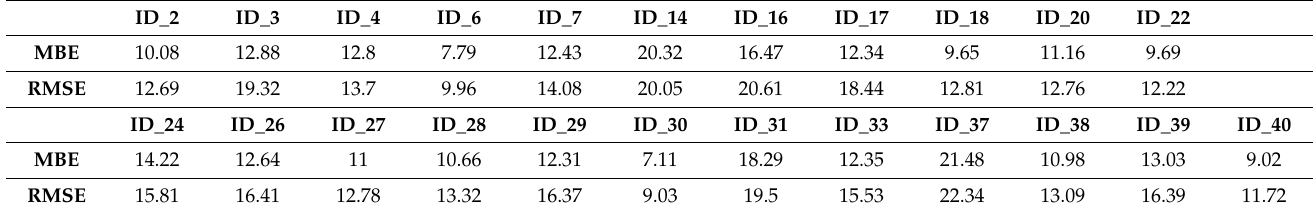
Table 8. Mean Bias Error (MBE) and Root Mean Square Error (RMSE) comparing the calibrated temperatures provided by our sensors against those provided by the Design-Builder